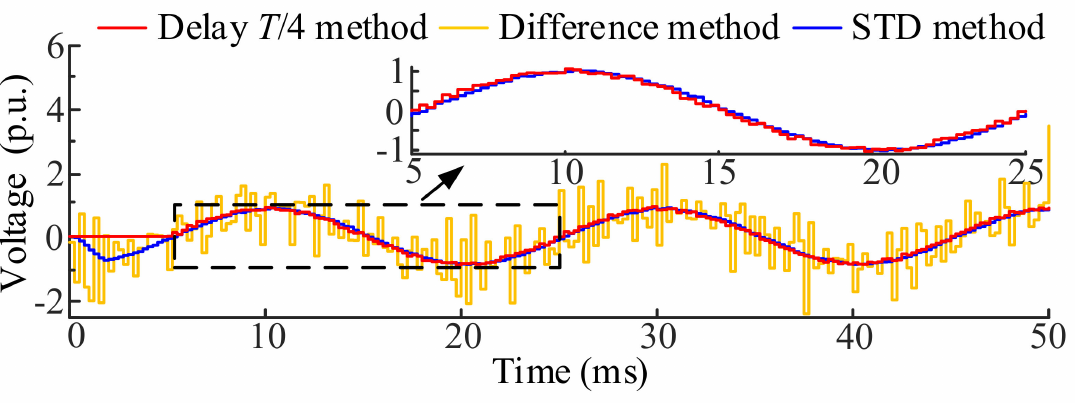
Figure 6. Noise sensitivity simulation of different quadrature signal construction algorithms without filter.